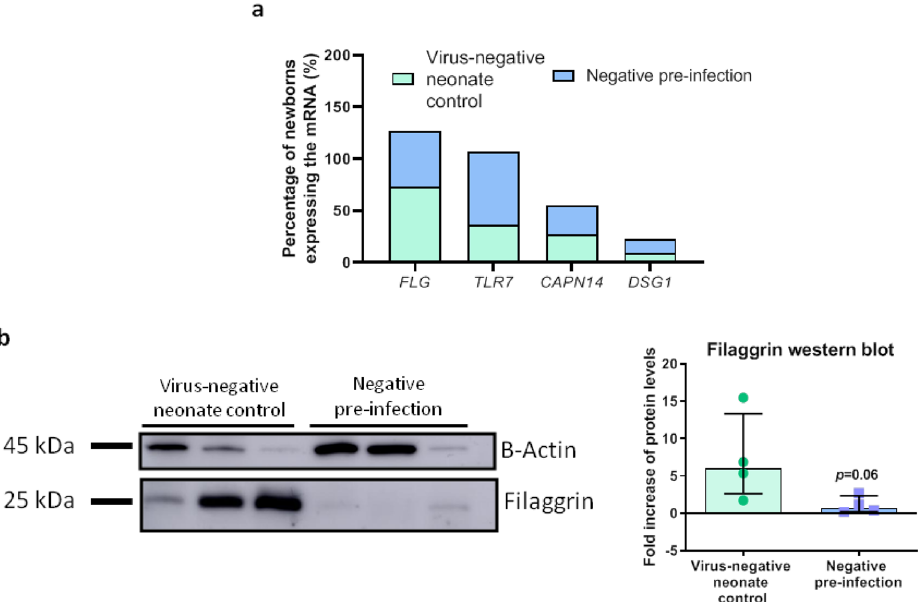
Figure 3. Gene expression and protein quantity of filaggrin in the NPA cells from neonates differs in virus- negative neonate controls compared to samples from negative pre infection subjects. ( a ) Percentage of neonates (negative pre-infection samples from virus-positive [ n = 7–11] and from virus-negative controls [ n = 11–19]) with mRNA expression in NPA cells measured by qPCR. Frequency analyses were performed using Fisher’s exact test. ( b ) Quantity of filaggrin in NPA cells from neonates measured by Western blot ( n = 4 for each group). Inter-group analysis was performed using Mann–Whitney U test. Bar graphs represent percentage ( a ) or median and interquartile ranges ( b ). kDA